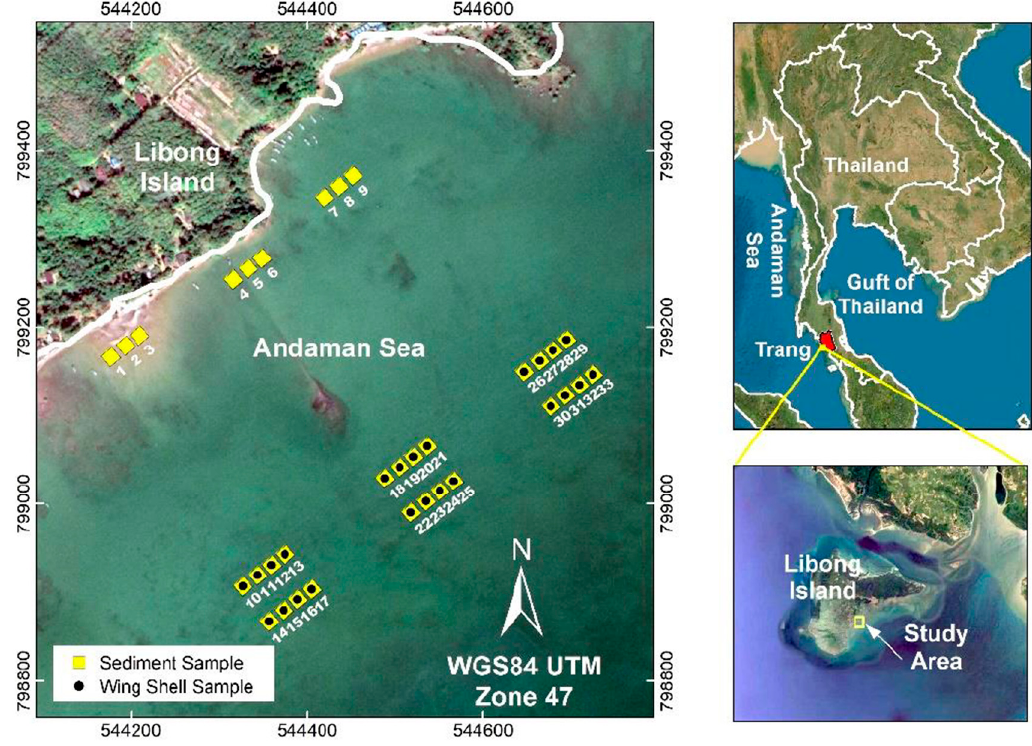
Figure 1. Sampling stations at Libong Island, Thailand.